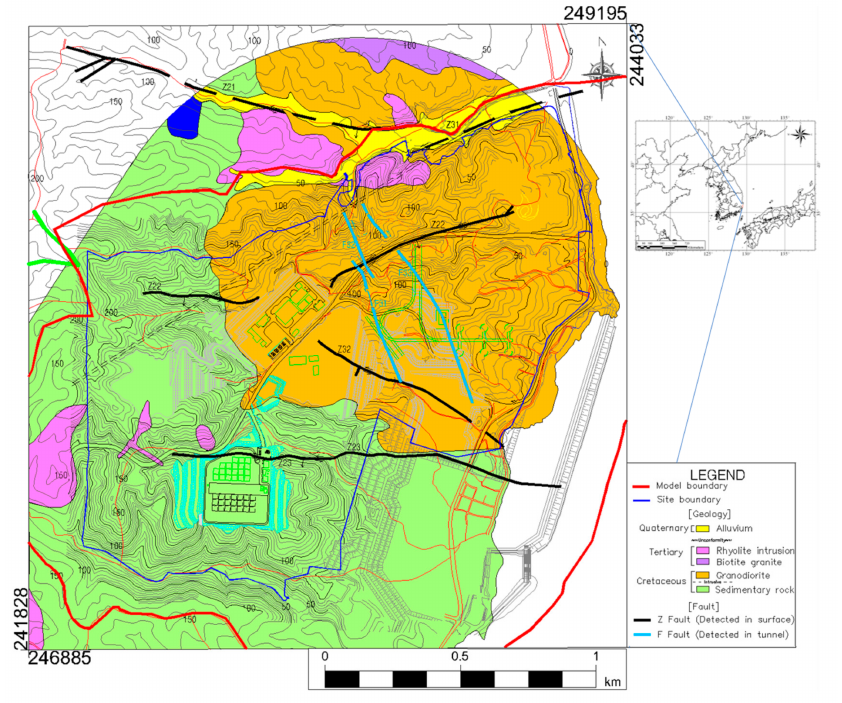
Figure 2. Geology of the study area.